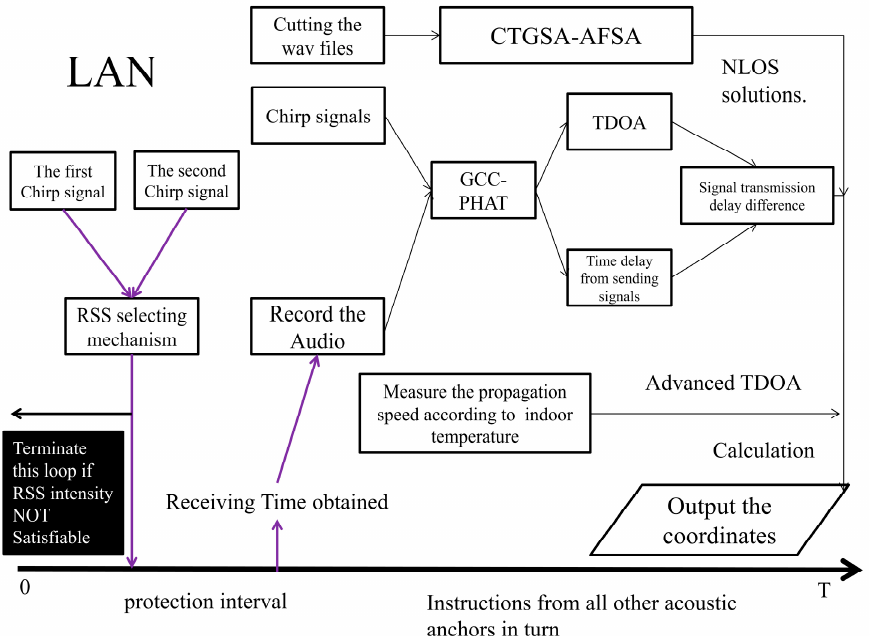
Figure 7. Main anchor working time axis in one localization loop. The NLOS solutions are adopted from [22].